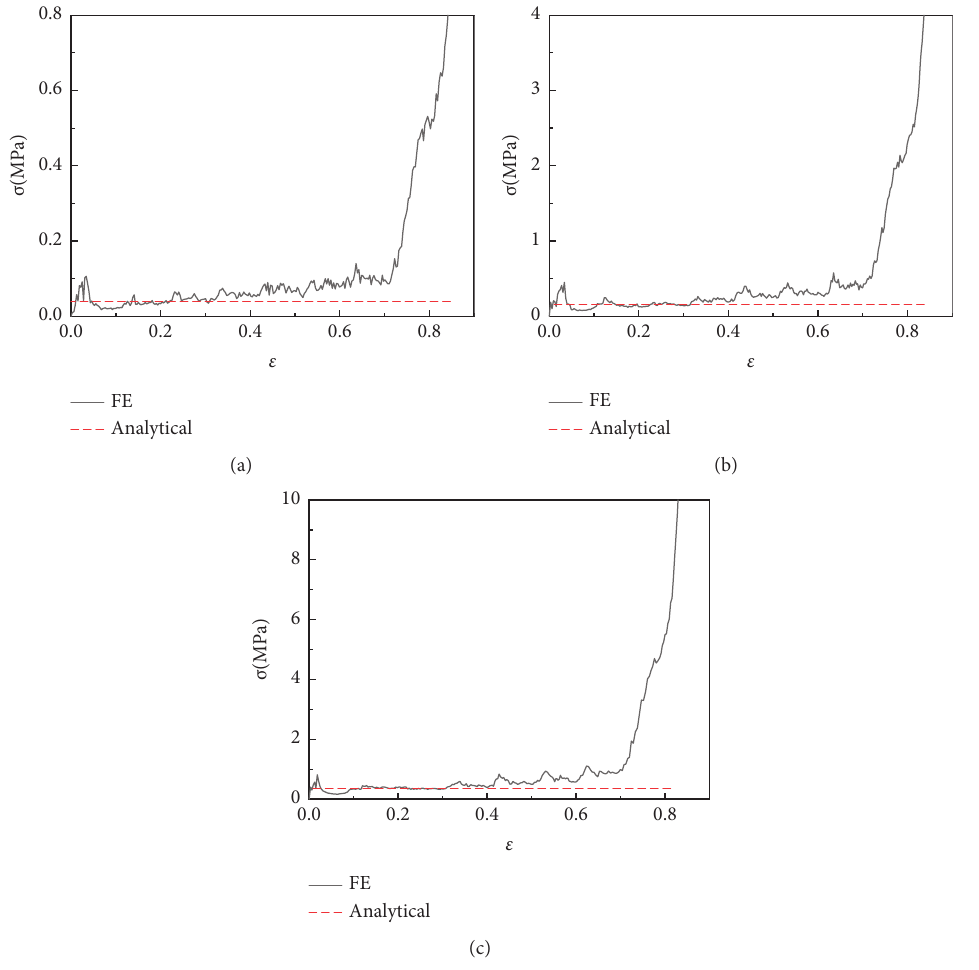
Figure 10: FE prediction of the quasi-static collapse response of DHHs with different relative densities, N � 12. (a) ρ � 2 . 5%. (b) ρ � 5%. (c) ρ � 7 . 5%. The direction of impact is z .